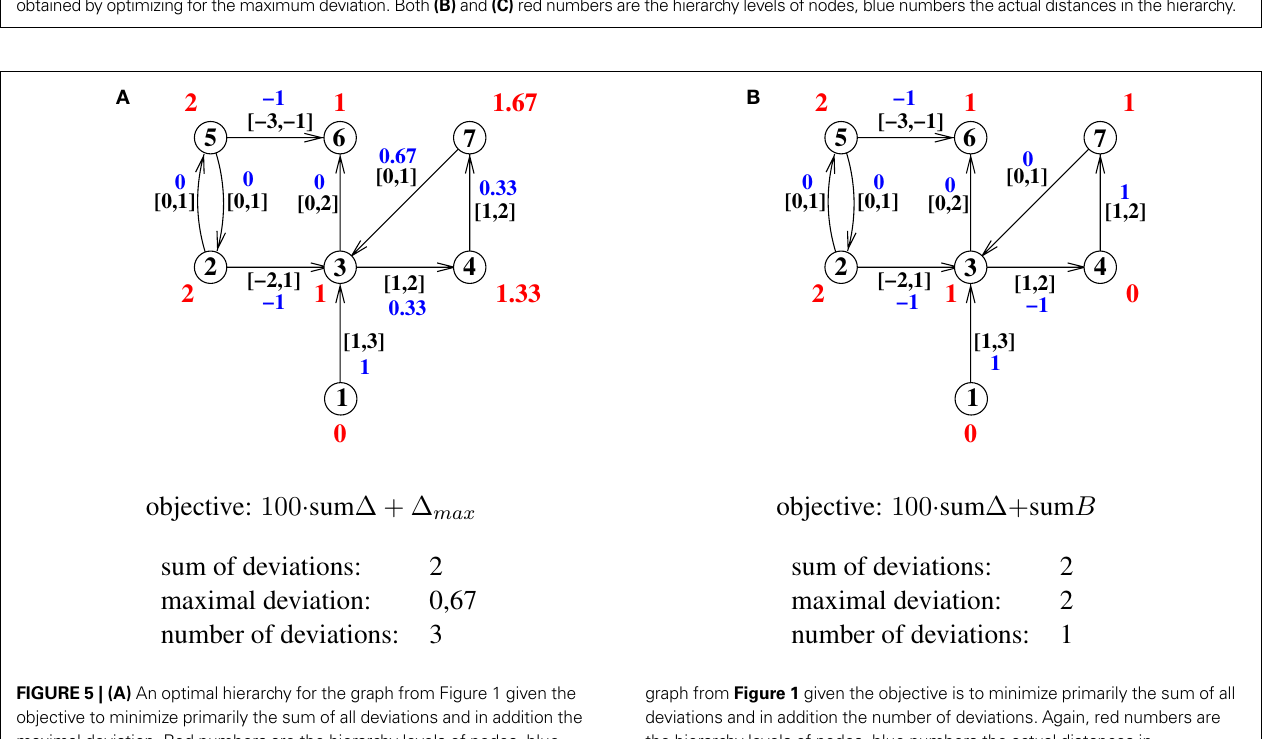
FIGURE 5 | (A) An optimal hierarchy for the graph from Figure 1 given the objective to minimize primarily the sum of all deviations and in addition the maximal deviation. Red numbers are the hierarchy levels of nodes, blue numbers the actual distances in the hierarchy. (B) An optimal hierarchy for the